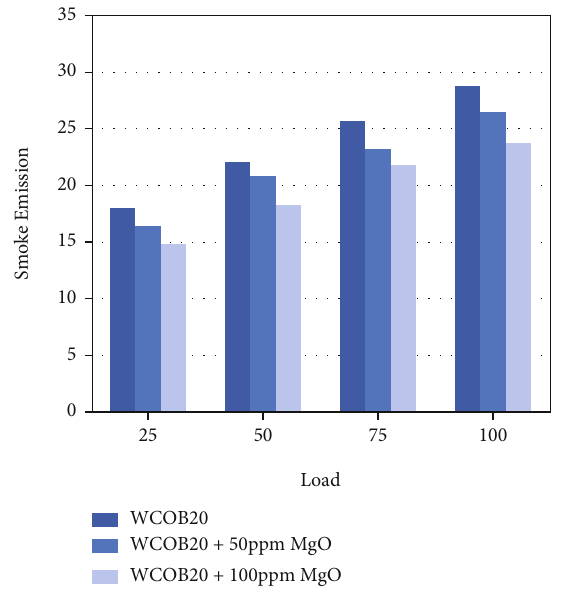
Figure 12: Smoke emission vs.